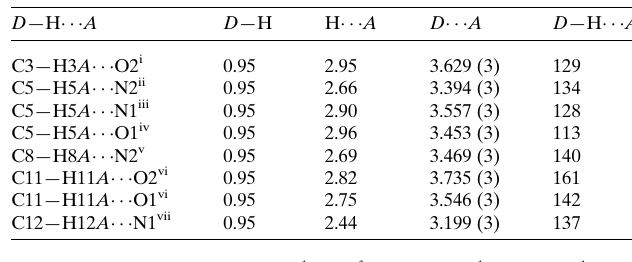
Table 1 Hydrogen-bond geometry (A˚ , (cid:2) ) for o -C 15 H 10 N 2 O 2